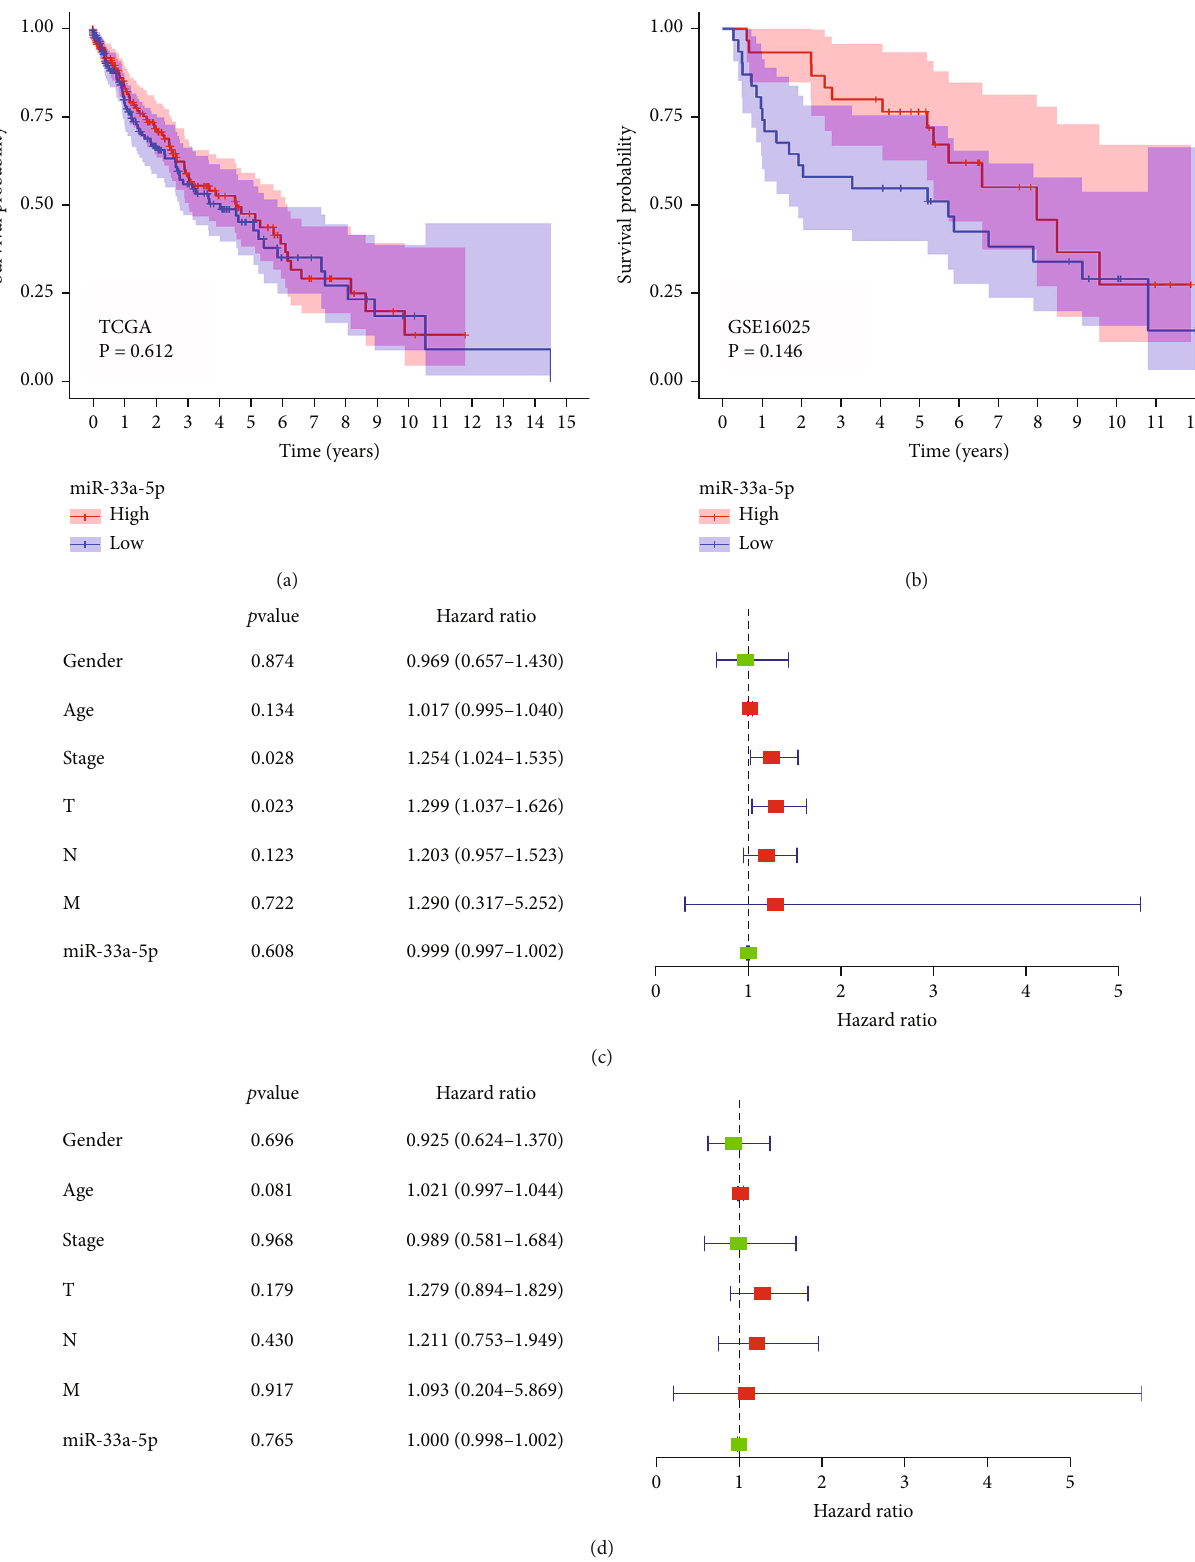
Figure 6: Prognostic analysis of miRNA-33a-5p in LUSC. (a, b) Survival analysis of miRNA-33a-5p based on TCGA and GSE16025, respectively. (c, d) Cox regression analysis for the prognostic value of miRNA-33a-5p and LUSC clinicopathological parameters according to univariate Cox and multivariate Cox regression analysis, respectively. P < 0 : 05 indicated statistically signi fi cant di ff erence. TCGA: The Cancer Genome Atlas; T: tumor; N: node; M: